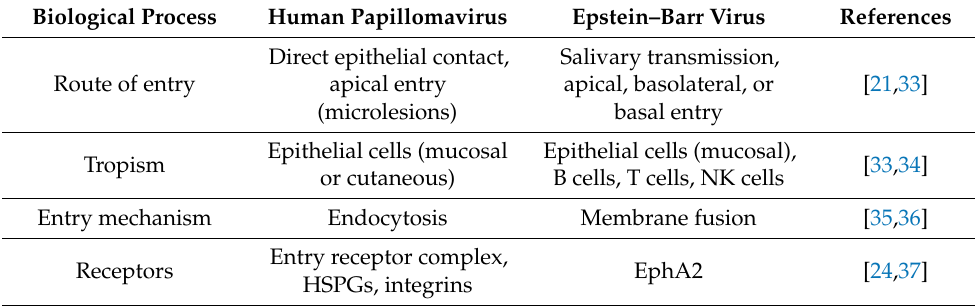
Table 1. Comparison between HPV and EBV epithelial cell